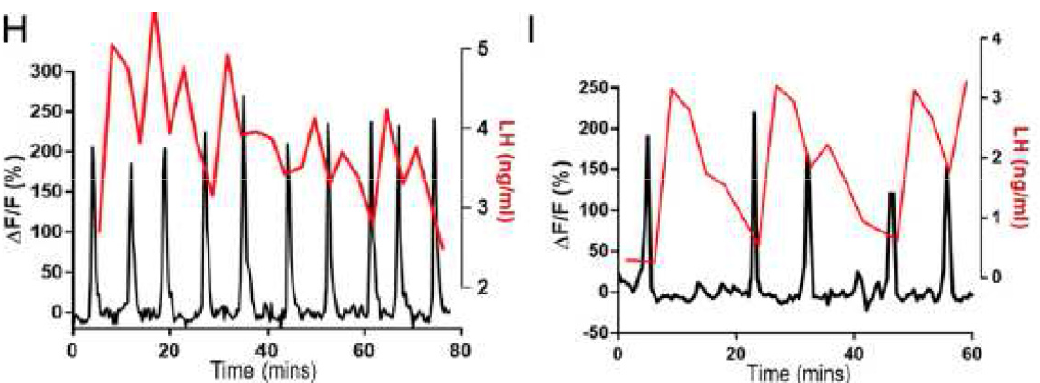
Figure 5. Electrophysiological activity in KNDy neurons is tightly correlated with discharges of luteinizing hormone in mouse. High- fidelity correlation between electrophysiological activity (reflected by intracellular Ca ++ ) of kisspeptin (KNDy) neurons in the arcuate nucleus of gonadectomized male mice monitored in vivo using an optogenetic approach (black trace) and the pulsatile secretion of luteinizing hormone (LH) (red) as tracked by measuring plasma concentrations of the gonadotropin. Reproduced from Clarkson et al. 57 with permission from the National Academy of